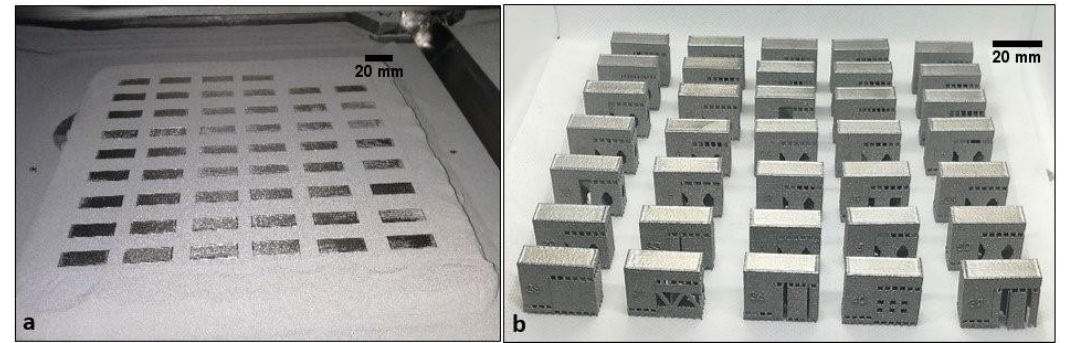
Figure 2. Fabricated specimens: ( a ) specimens on sintered powder; ( b ) specimens after sand blasting.